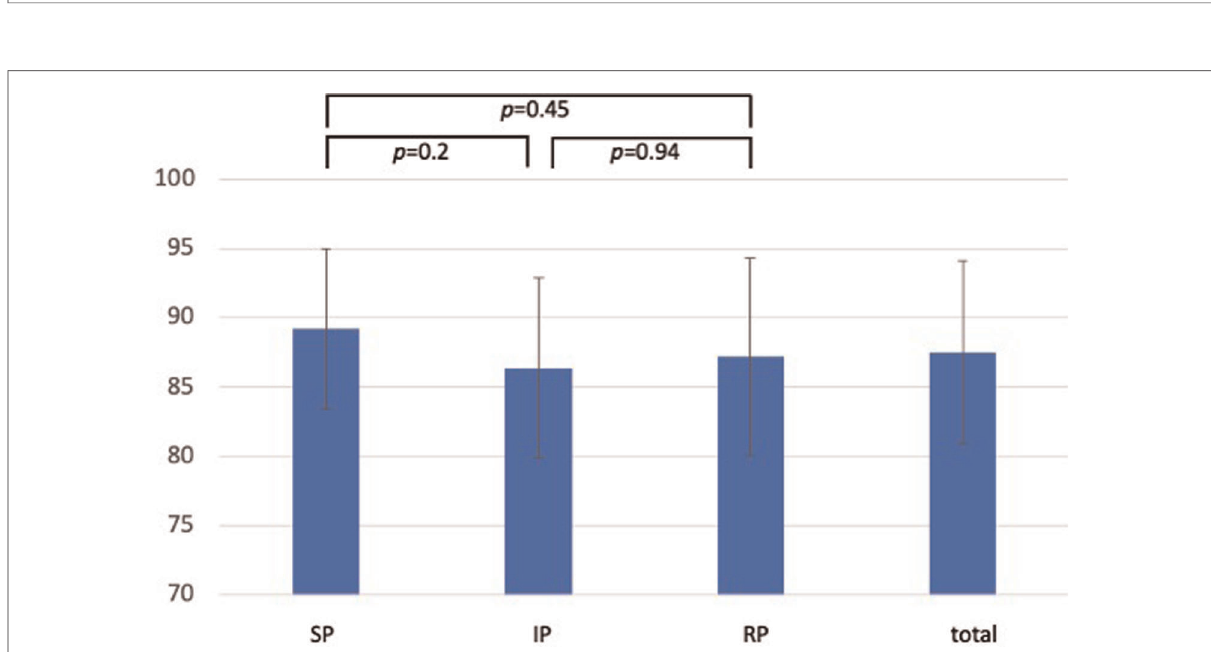
FIGURE 2 OSCE results for the second part (aspects of interaction) of the evaluation sheet. Results of the rating for aspects of interaction. Data are presented as the mean±standard deviation of the achieved results as a percentage. (SP-group, simulated patient group; IP-group, incognito patient group; RP-group, real patient